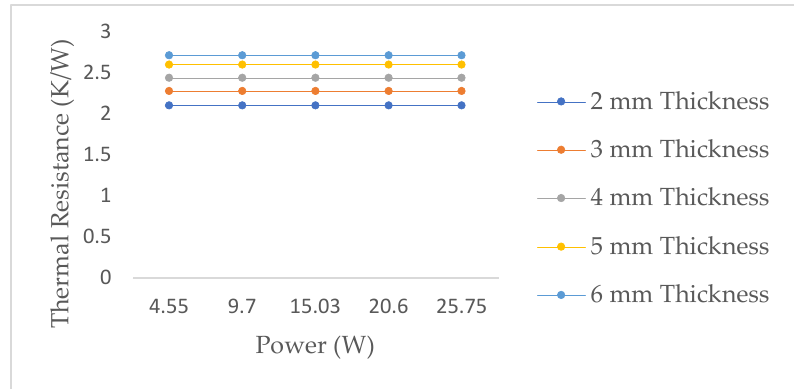
Figure 10. Thermal resistance relative to the power input.